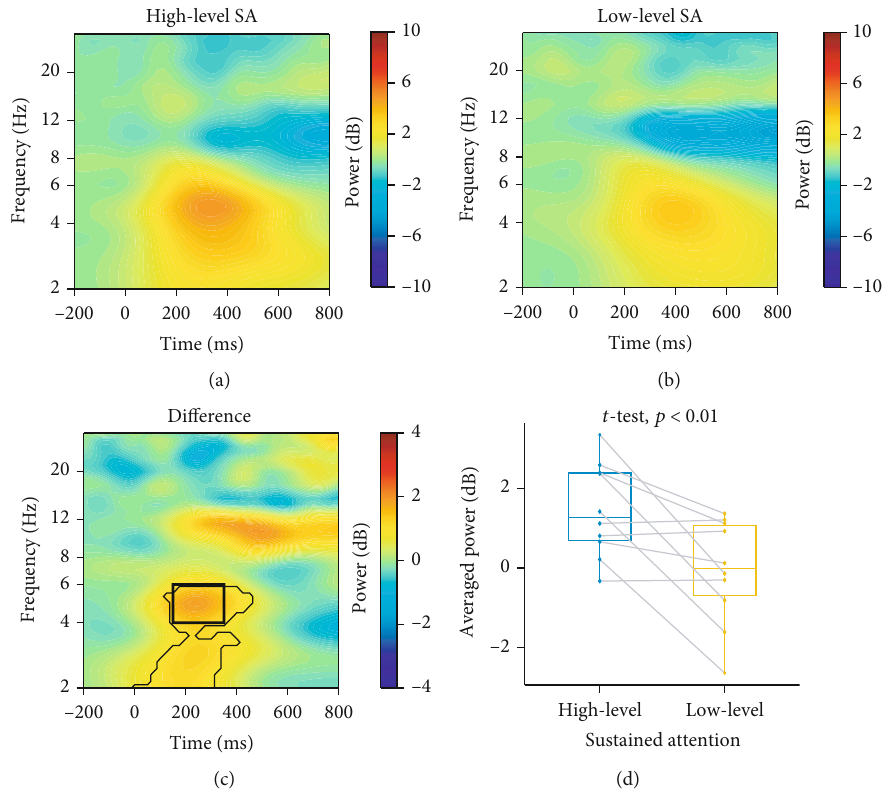
Figure 4: Time-frequency power of pMFC (Fz). The power of (a) high-level and (b) low-level sustained attention (here abbreviated as SA) was computed by averaging across all subjects. (c) Districts circled in thin lines denote a signi fi cant di ff erence between high-level and low- level sustained attention (high-level minus low-level). The bold black rectangle shows the interested time-frequency window (150-350 ms and 4-6 Hz). (d) The averaged power of high-level sustained attention was signi fi cantly larger than that of low-level sustained attention, t ð 9 Þ = 3 : 30 , p < 0 : 01 .